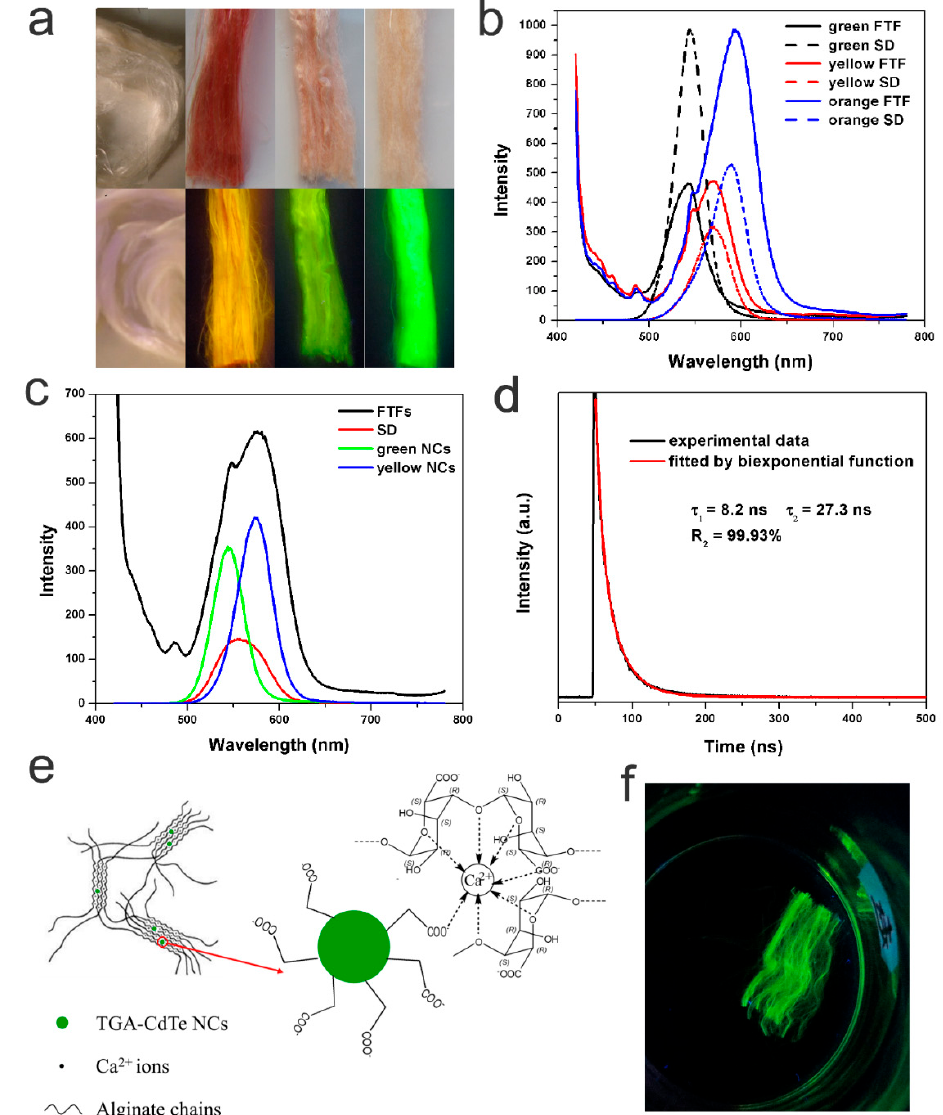
Figure 3. ( a ) Optical images of CTFs and FTFs with different colours under ambient light (upper) and excited by 365 nm UV light (lower). ( b ) Photoluminescence (PL) spectra of FTFs and corresponding SDs. ( c ) PL spectra of FTFs doped with two kinds of CdTe NCs. ( d ) Fluorescence decay profiles of FTFs with an excitation wavelength 365 nm. ( e ) Schematic illustration of the composition of FTFs. ( f ) Optical image of FTFs soaking in water for 2 days.